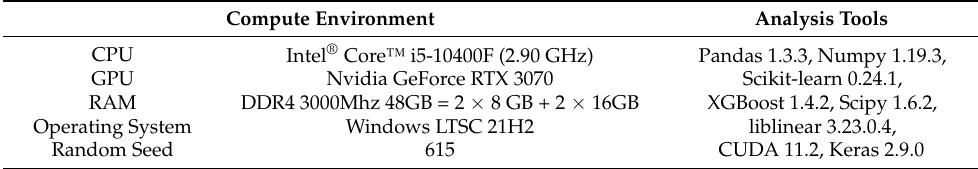
Table 3. Environment and tools of analysis and model building in